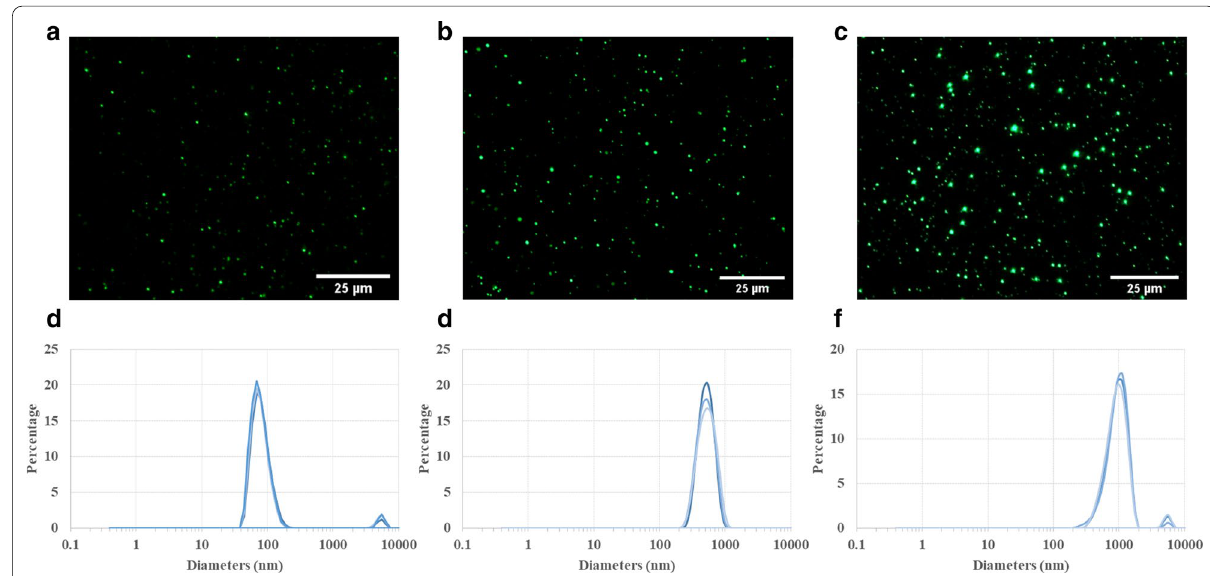
Fig. 1 Characterization of PLGA particles. Fluorescence micrographs show the different sizes ( a 100 nm, b 500 nm, and c 1 µm) of PLGA particles. Those particles can be detected under Olympus Optical Microscopy exhibiting relative uniform particle size distributions in water suspension. Dynamic light scattering (DLS) measurements display the size distribution weighted by volume for 100 nm ( d ), 500 ( e ), 1 µm ( f ) PLGA particles. Despite a small part of particle aggregation (smaller peaks: 3–4%) in 100 nm and 1 µm PLGA suspensions, the overall particle size distribution is quite homogeneous because of the narrow main